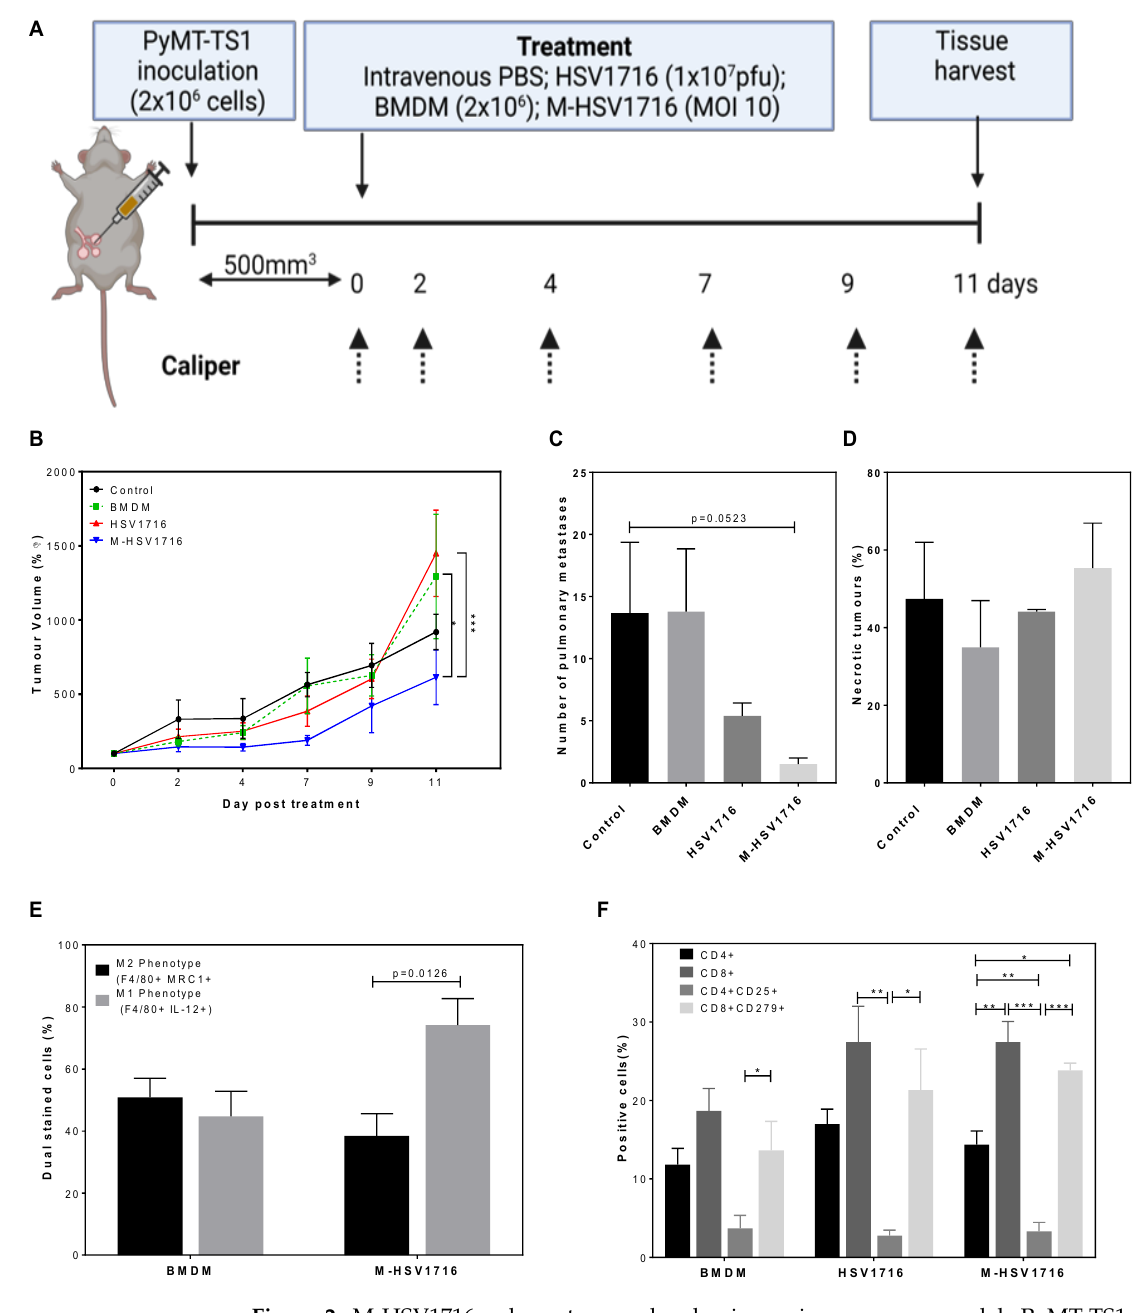
Figure 2. M-HSV1716 reduces tumour burden in a primary mouse model. PyMT-TS1 cells were implanted into the 4th mammary fat pads to assess the effectiveness of HSV1716 or M-HSV1716 in primary tumours ( A ). Tumour growth was measured by digital calipers for 11 days following treatment ( B ). Pulmonary metastases ( C ) and necrosis ( D ) were quantified histologically postmortem from an average of 2–4 different sections of lung tissue over 100 µ m apart from 2–4 slides. Immune cell changes within the TME were seen when M-HS1716 was given compared to macrophage alone. Flow cytometric analysis of dispersed tumours showed a skewing to M1 macrophage phenotype ( E ) and an increase in CD8+ T cells ( F ). Data are mean ± SEM, n = 6–8 mice per group. * = p < 0.05, ** = p < 0.01, on 6 October